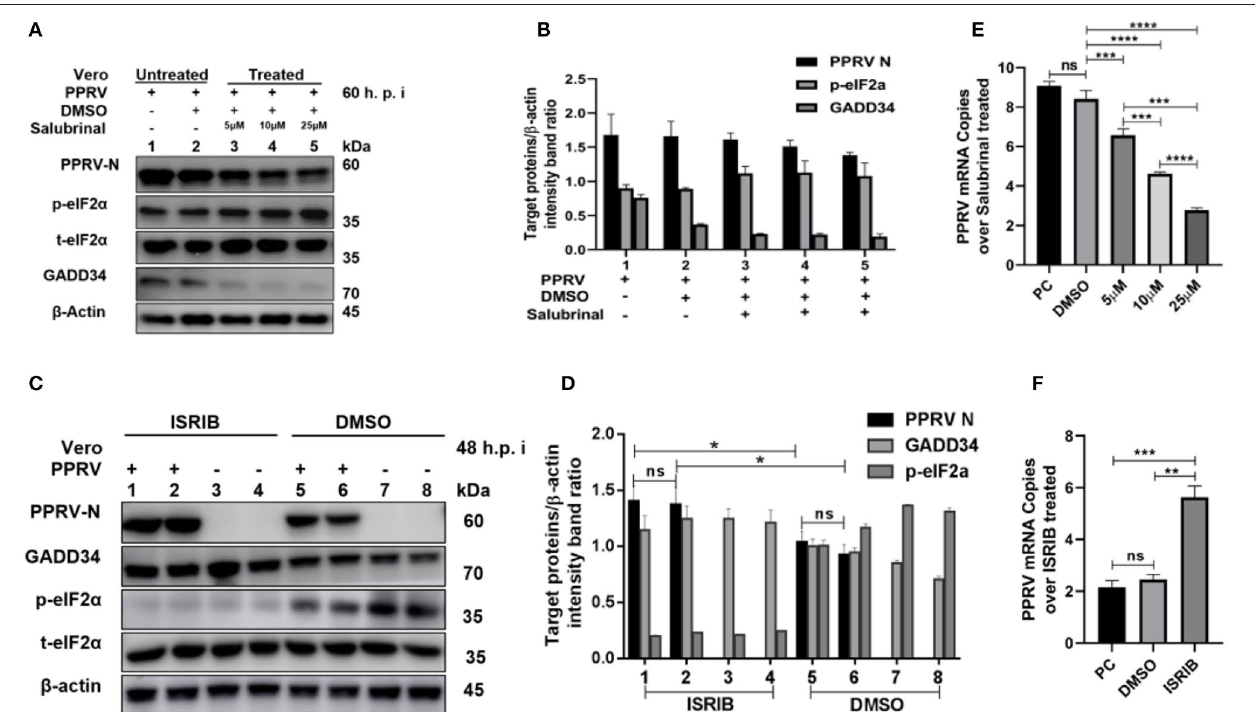
FIGURE 4 | Inhibition of eIF2 α dephosphorylation is beneficial to PPRV replication. Vero cells were infected with PPRV or mock-infected. (A,C) After 2-h adsorption, infection media was replaced by fresh media treated with 5, 10, and 25 µ M of Salubrinal in (A) or ISRIB (200nM) in (C) and incubated up to 60h.p.i. for Salubrinal and 48h.p.i. for ISRIB. Treatment with DMSO alone was used as control. The effect of PPRV on p-eIF2 α in treated or untreated groups were analyzed by Western blot. (B,D) Densitometry quantification of p-eIF2 α , GADD34, and PPRV-N was normalized to β -actin and fold change between treated and untreated was determined by ImageJ analysis. Statistical analysis was performed using GraphPad Prism 8.0 software. On the graphs, shown are representative immunoblots with the error bars representing the mean ± SD from three independent experiments. (E,F) RT-qPCR was used to quantify the mRNA levels of PPRV in samples treated or untreated with Salubrinal (E) or ISRIB (F) . Viral RNA of the positive control (PC) or vehicle treated with DMSO were compared to that of Salubrinal or ISRIB treated groups. The mean ± standard deviation (SD) was obtained in triplicate ( n = 3). Statistical analysis was performed using GraphPad Prism 8.0 software using multiple t -tests. Asterisks represent statistically significant differences between treated and untreated groups (* P < 0.05; ** P < 0.01; *** P < 0.001; **** P < 0.0001; ns, not